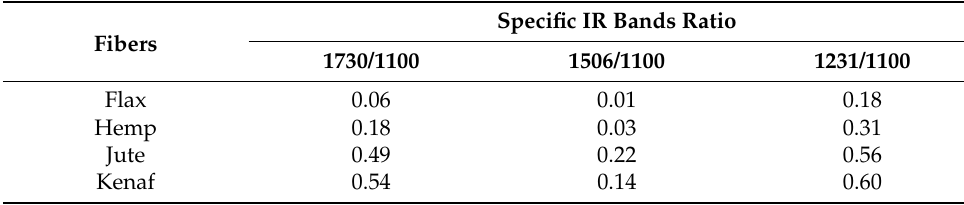
Figure 1. ATR infrared spectra of lignocellulosic polymer films ( a ) and plant fibers ( b ). The vertical lines indicate four main band variations observed that are specific to the composition of films and fibers in polymers (cellulose, hemicelluloses, and lignin). Table 1. Calculated specific IR bands ratio in blast fibers.